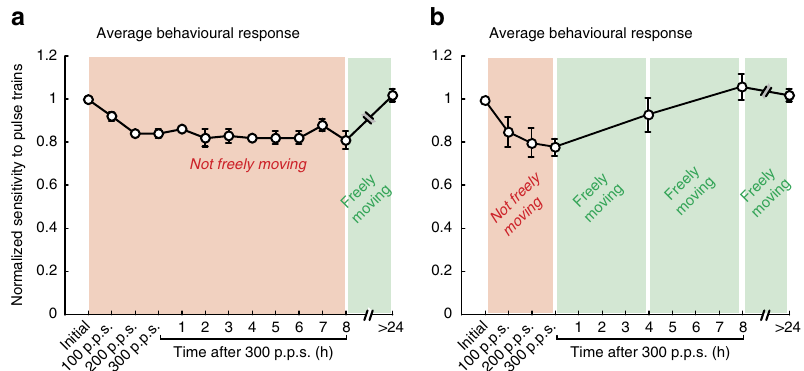
Figure 7 | Behavioural recovery following vestibular nerve activation. ( a ) Normalized eye velocity gain over an 8-h period following activation of the vestibular nerve when the animal remained stationary. ( b ) Normalized eye velocity gain over an 8-h period following activation of the vestibular nerve when the animal was returned to its home cage in between testing sessions. Error bars represent ±